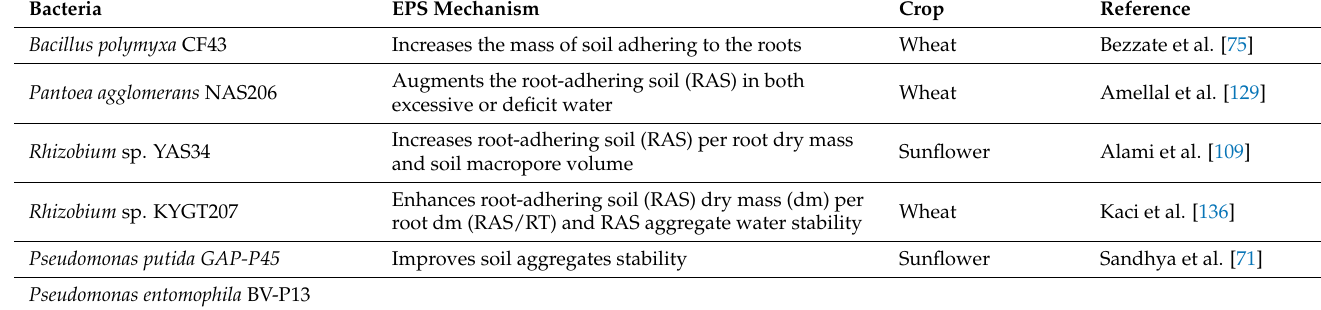
Table 2. PGPR’s mechanisms to alleviate drought stress in